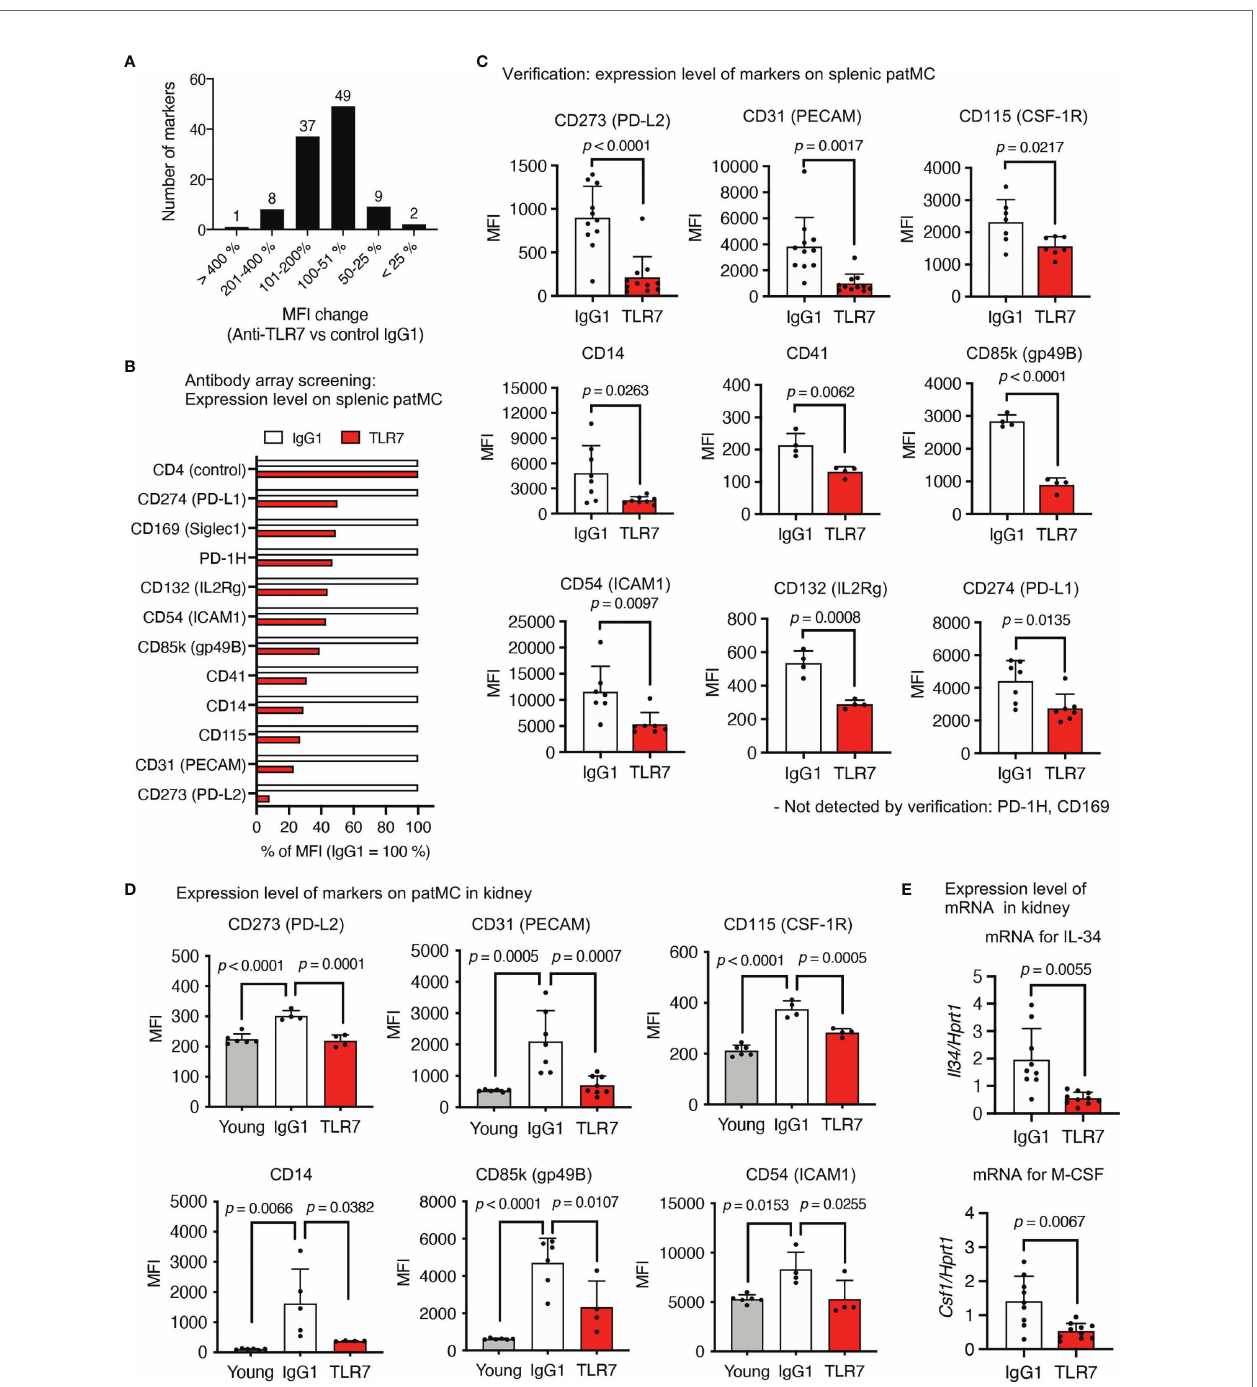
FIGURE 8 | TLR7-dependent expression of the cell surface molecules on patrolling monocytes in NZBWF1 mice. (A – E) NZBWF1 mice were administered saline, IgG1 or the anti-TLR7 mAb from age of 12-16 to 35-40 weeks. Young (pre-onset) untreated NZBWF1 mice were analyzed at 12 weeks of age. (A) Splenic patrolling monocytes were stained using LEGENDScreen antibody array. Distribution of ratios (%) of anti-TLR7 to IgG1 treatment is shown. (B) Mean fl uorescent intensity of markers with > 50% less expression caused by anti-TLR7. Results are average values from four mice. (C) Expression of markers on patrolling monocytes in spleen. Control IgG1 ( n ≥ 4), and anti-TLR7 mAb ( n ≥ 4). (D) Expression of markers on patrolling monocytes in kidneys. Young (pre-onset) 12-week-old NZBWF1 mice were controls. Young mice ( n = 6), control IgG1 ( n ≥ 4), and anti-TLR7 ( n ≥ 4). (E) Expression of mRNA encoding IL-34 and M-CSF in kidneys analyzed by real-time PCR. Results are normalized to Hprt1 mRNA. Control IgG1 ( n ≥ 7), and anti-TLR7 ( n ≥ 6). Data were statistically analyzed by Student ’ s t-tests, Welch ’ s t-tests (C, E) , or one-way ANOVA (D) . The results found signi fi cant by ANOVA ( p < 0.05) were further assessed by Tukey ’ s multiple comparison tests. Data are shown as individual points and as means ± SD for each experimental group (C – E)